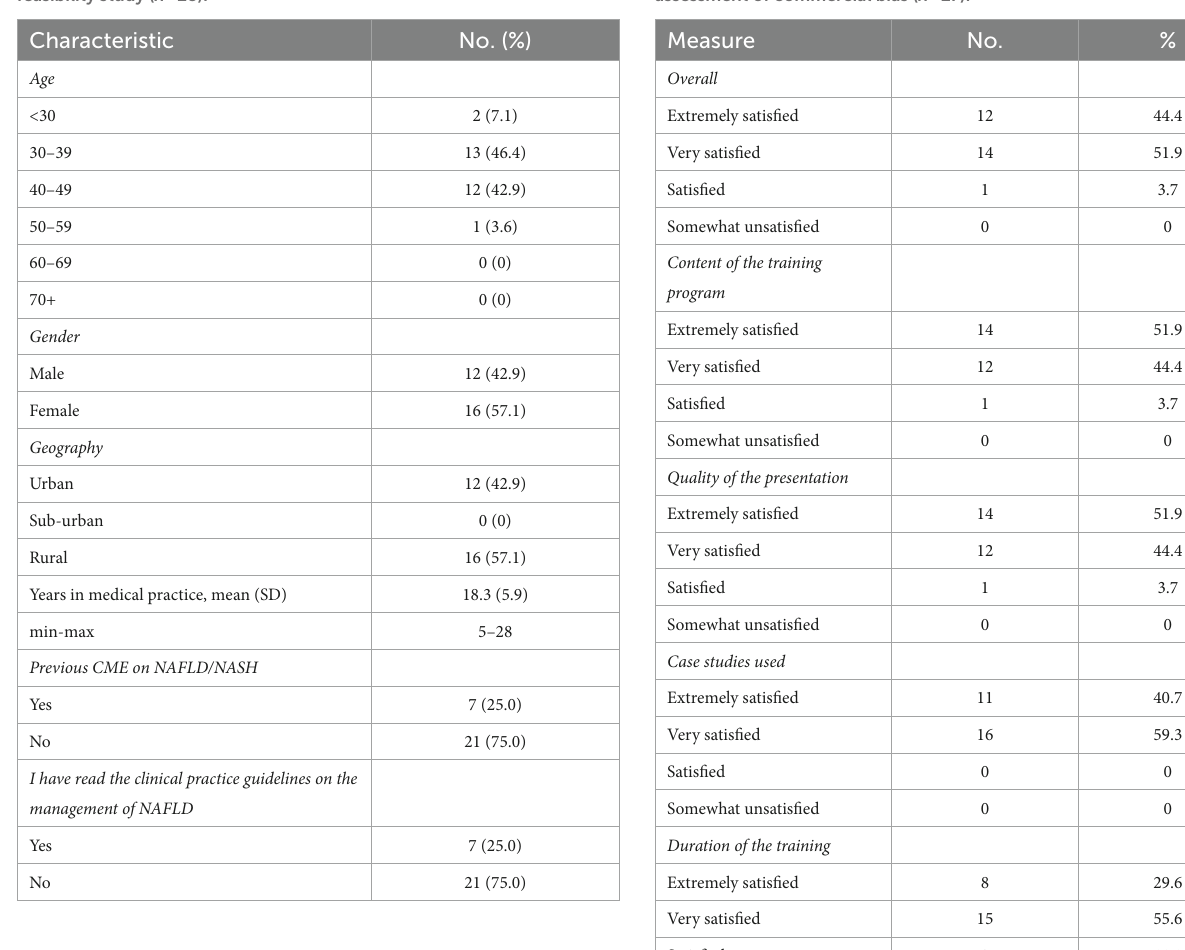
TABLE 2 Satisfaction with continuing medical education (CME) and assessment of commercial bias ( n =